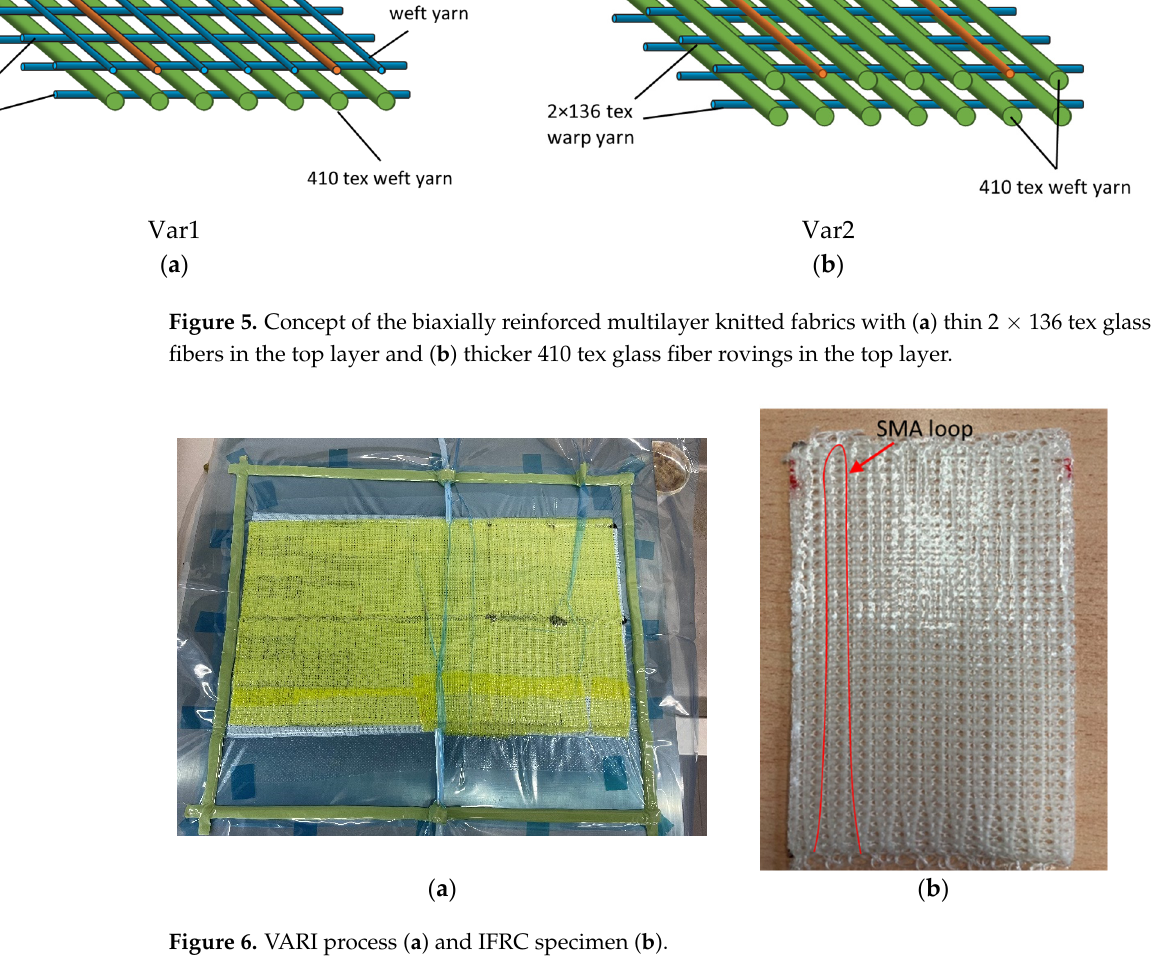
Table 1. Composite layup for the production of fiber–rubber composites.